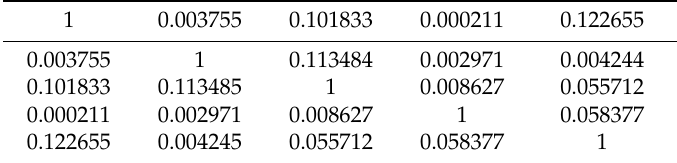
Table 4. The values of MAC by